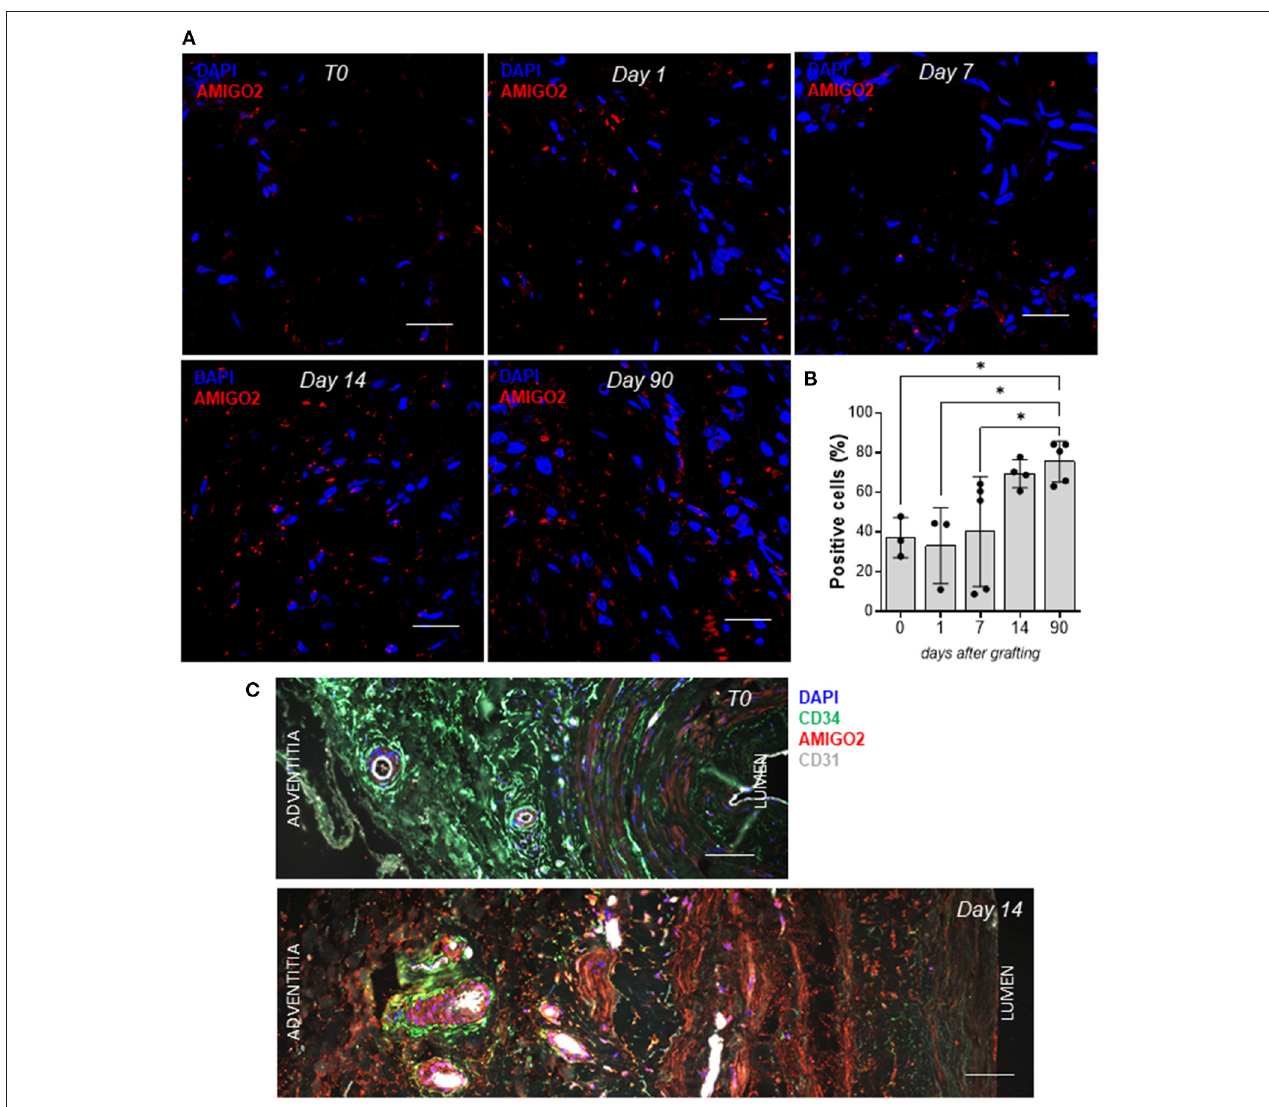
FIGURE 9 | AMIGO2 expression in vein graft remodeling. (A) Confocal microscopy analysis of paraffin-embedded porcine SVs for AMIGO2 (red) expression, nuclei are labeled with DAPI. Scale bar indicates 20 µ m. (B) Bar graphs showing the percentage of AMIGO2 positive cells in porcine SV adventitia after grafting into the carotid artery (T0: N = 3, Day 1: N = 3, Day 7: N = 5, Day 14: N = 4, Day 90: N = 5; all data shown as Mean ± SEM, * = p < 0.05). (C) Confocal microscopy analysis of paraffin-embedded human SVs for CD34 (green), AMIGO2 (red), CD31 (white), nuclei are labeled with DAPI. Scale bar indicates 50 µ